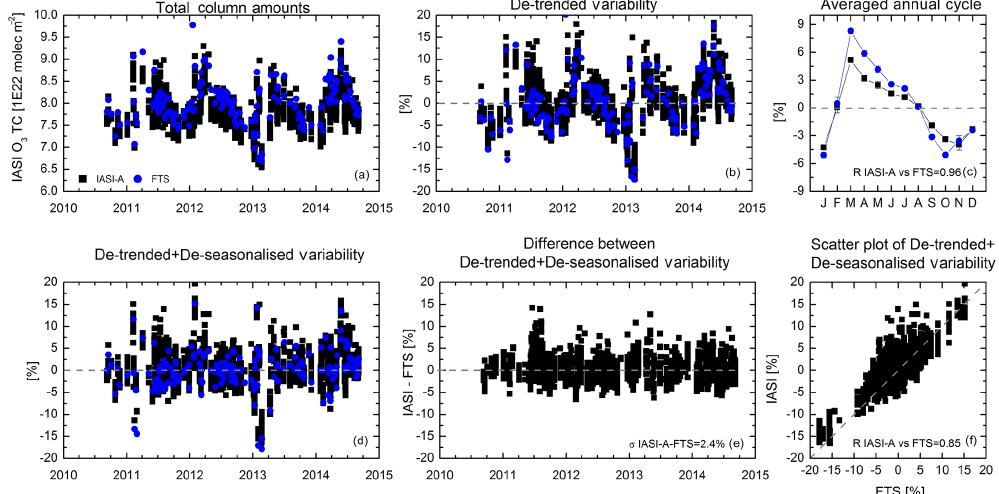
Figure 6. Summary of the IASI-A and FTS comparison for O 3 : (a, b) time series of the TC amounts (in 1 × 10 22 molecm − 2 ) and the de-trended variability (in %) respectively; (c) averaged annual cycle; (d, e) time series of the de-trended + de-seasonalised variability (in %), and the difference between coincident de-trended + de-seasonalised variability from IASI-A and FTS (in %) respectively; and (f) scatter plot of the de-trended + de-seasonalised variability. For (c) and (f) the Pearson correlation coefficient is included in the legends and for (e) the standard deviation of the differences. The number of coincident measurements is 2338.